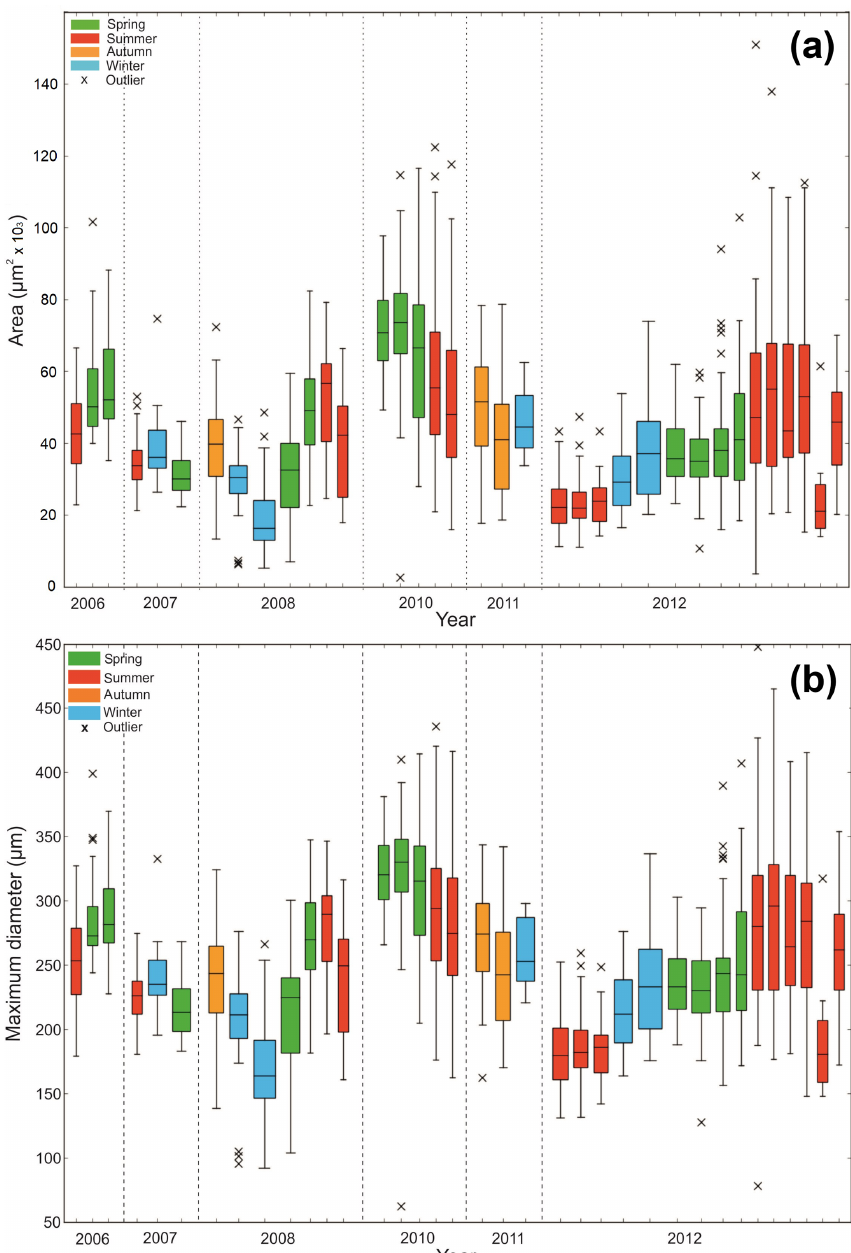
Figure 4. Boxplot of (a) Nps surface area and (b) maximum diameter records collected by manual morphological analysis. Crosses represent outliers defined by interquartile range. Dashed lines are visual divisions between the years. The width of each box represents the length of time that the collection cup was open in the sediment trap; the thinnest box is 7d, and the widest box is